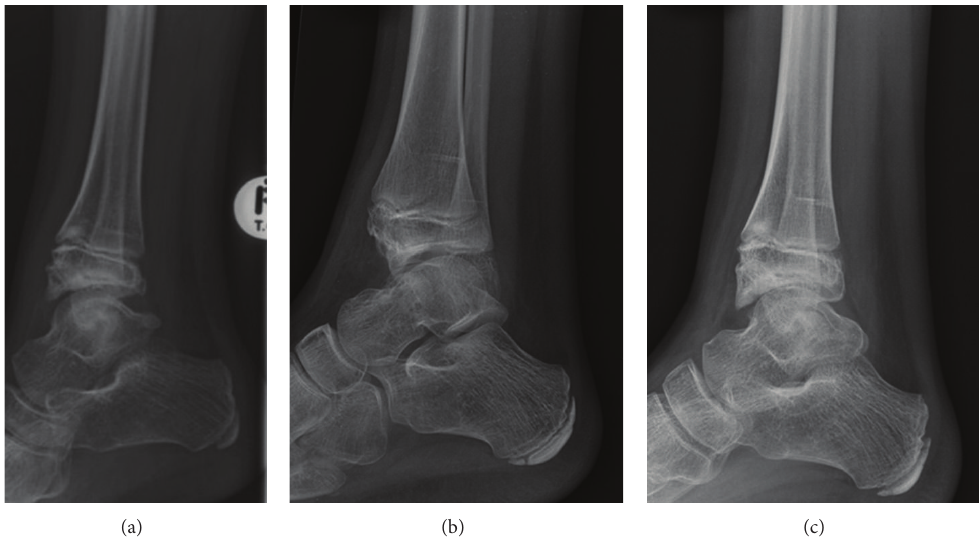
Figure 4: Serial X-rays: (a) preoperative in 2005, (b) postoperative in 2008, and (c) last followup in 2013, showing the lesion before and after its removal and the regrowth at the distal